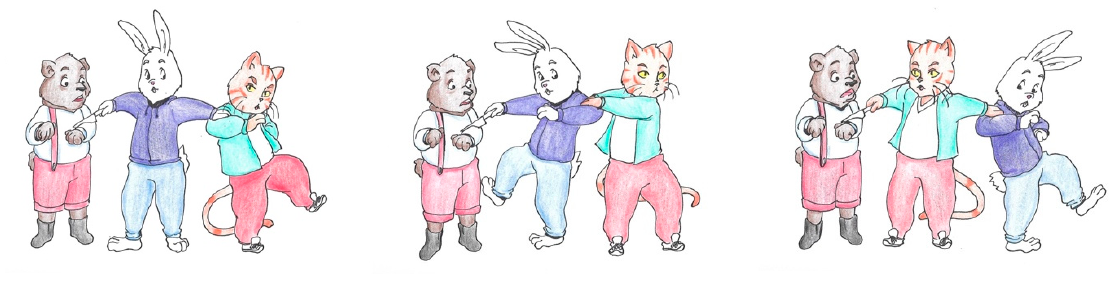
Figure A11. SRC stimulus 6.